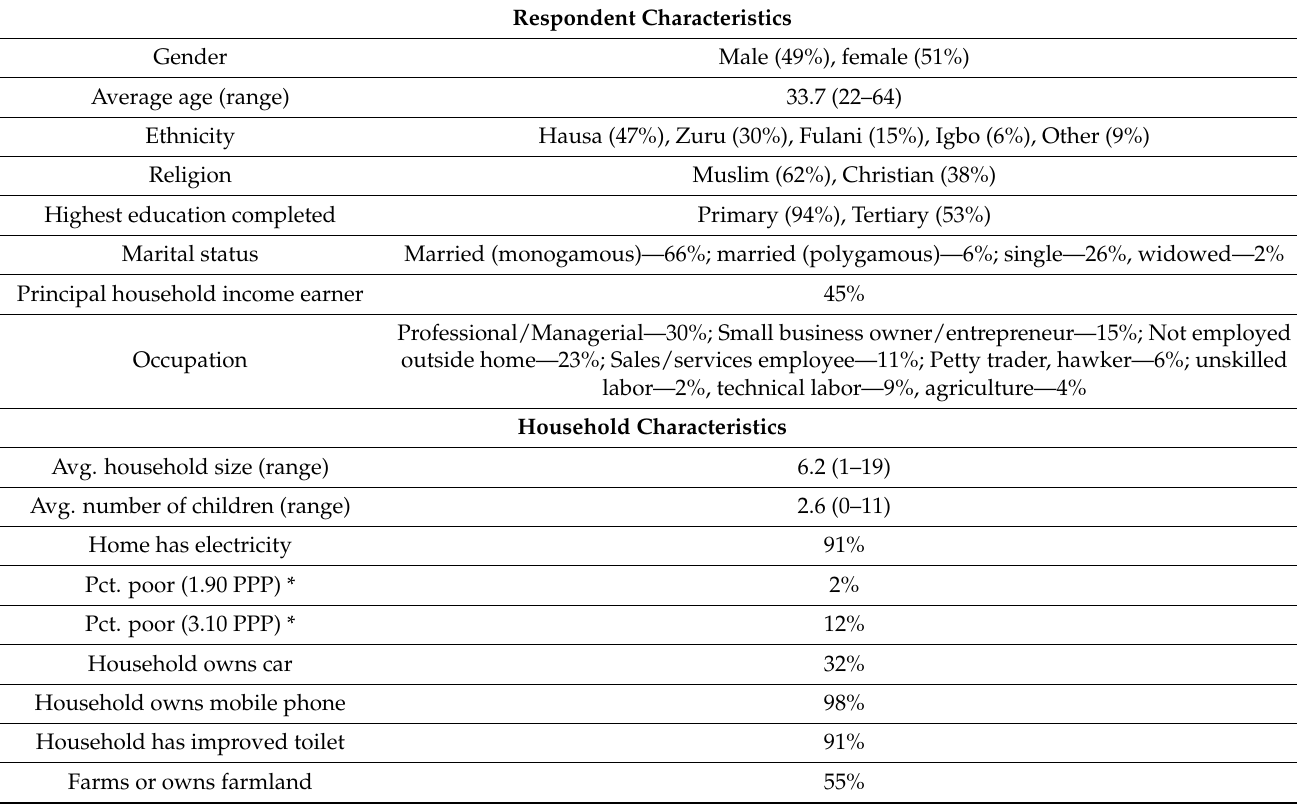
Table 1. Consumer demographic characteristics ( n = 47).